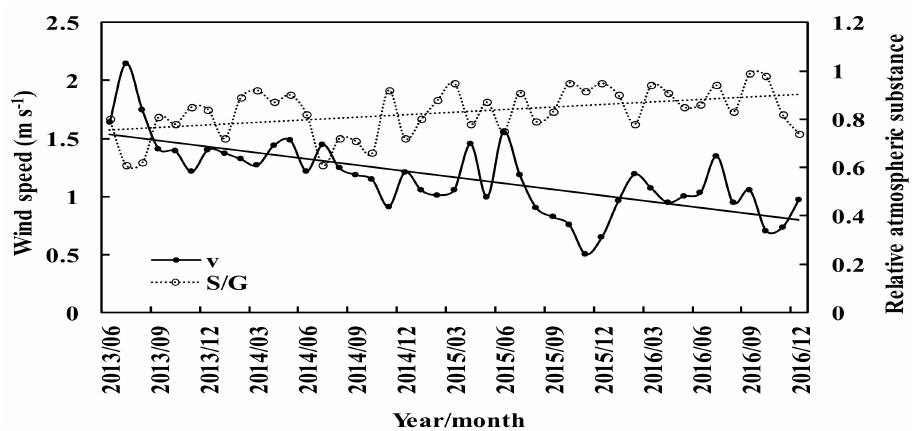
Figure 9. Monthly wind speed and monthly atmospheric substance over the Qianyanzhou subtropical Pinus plantation during the period from June 2013 to December 2016.